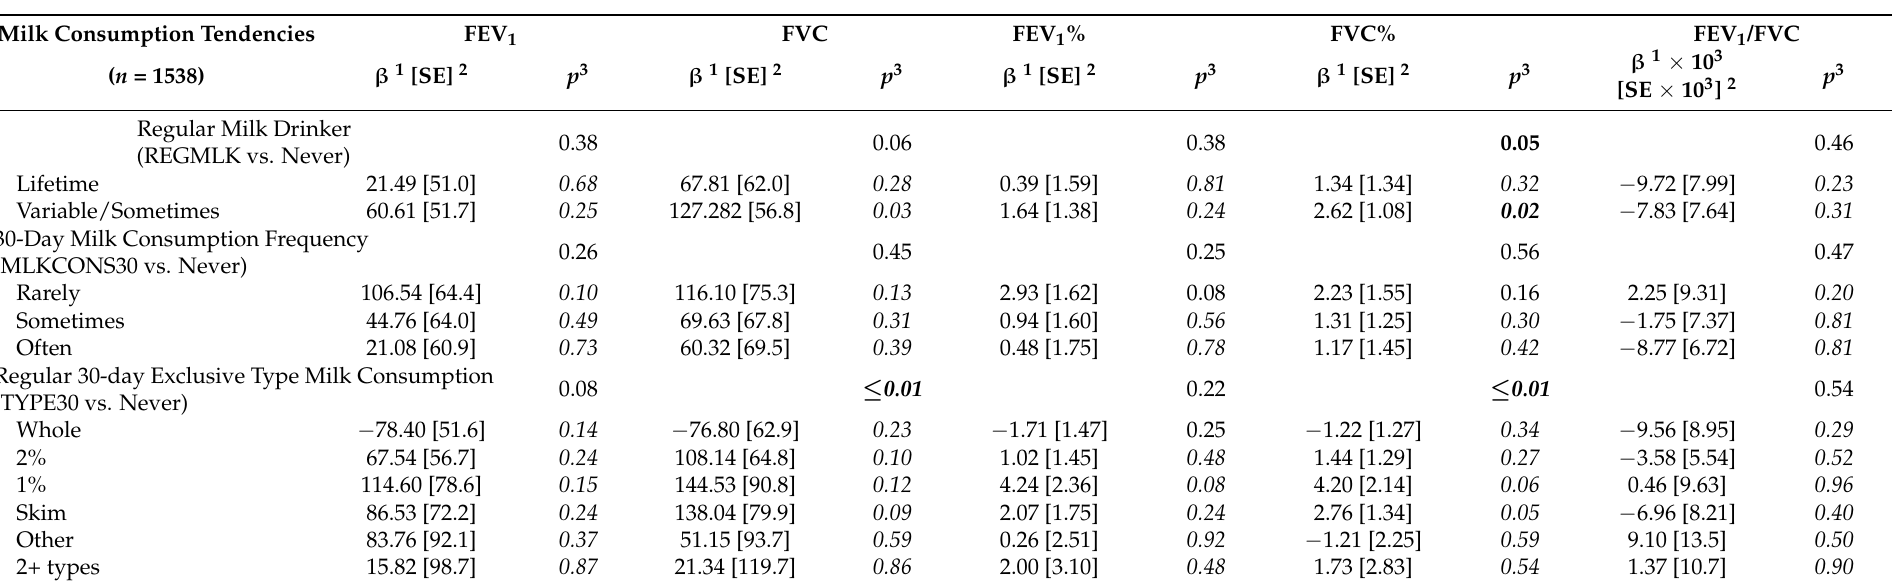
Table 5. Associations between milk consumption tendencies and lung function measurements in NHANES participants reporting past or current